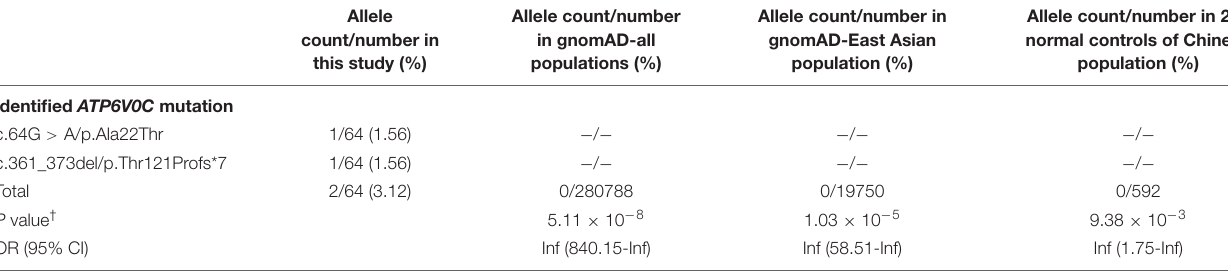
TABLE 1 | Analysis of the aggregate frequency of ATP6V0C variants identified in this study.